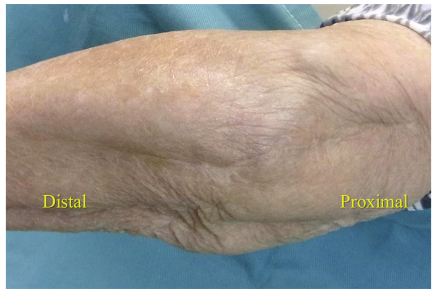
Figure 2: Nine months after reconstruction.